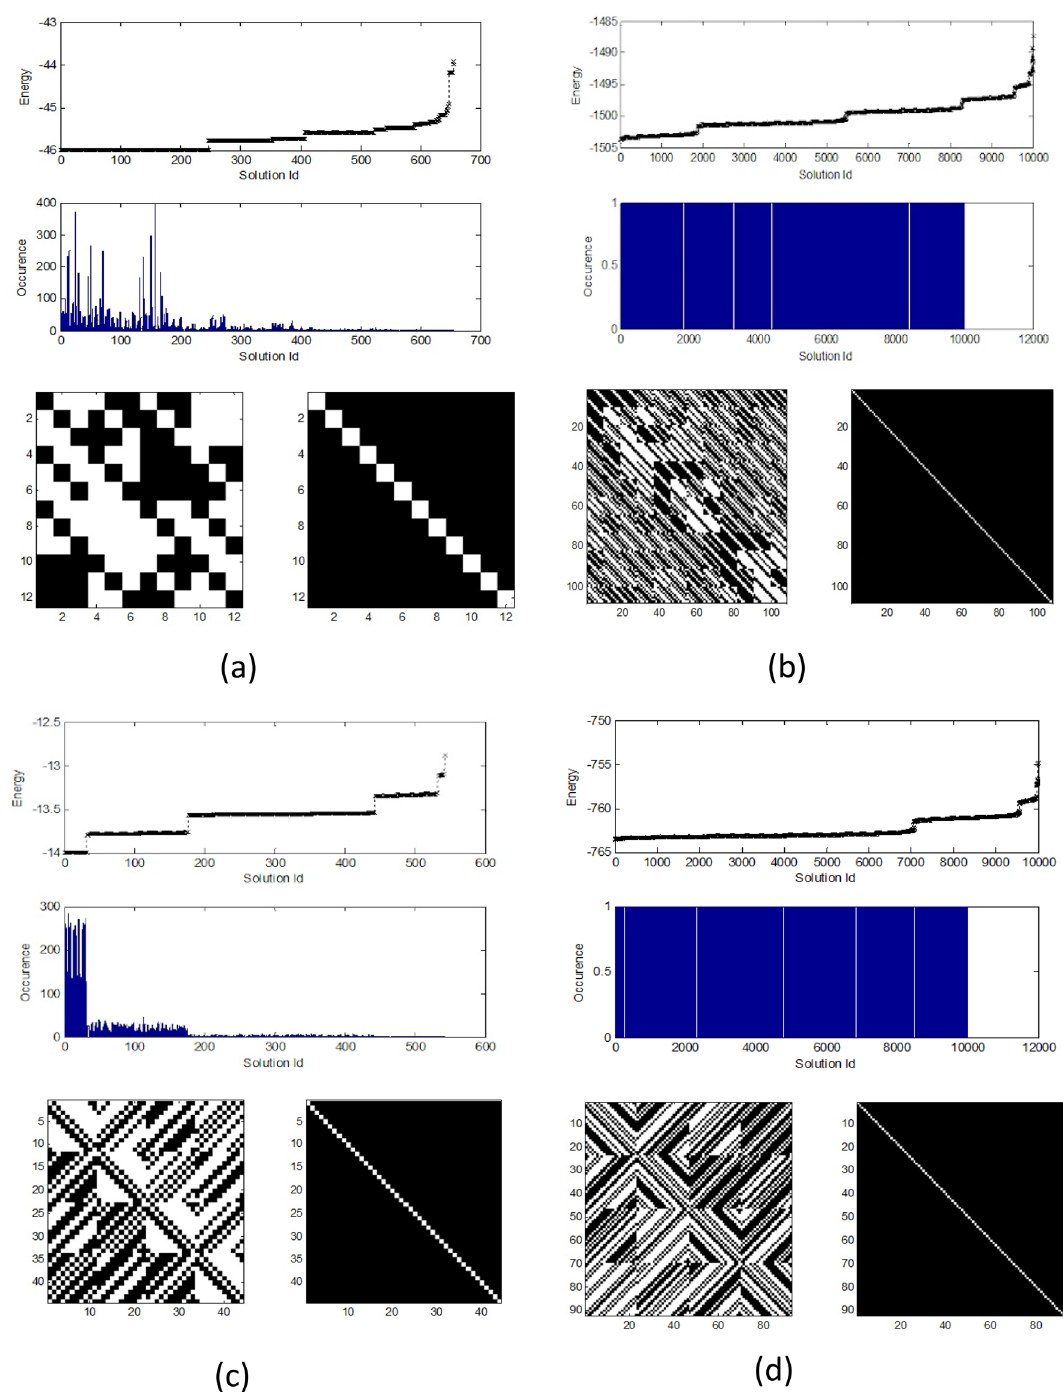
Figure 3. Experiment results of finding H-matrices using a quantum computer (D-Wave): ( a ) Williamson based method yields a 12 order H-matrix, ( b ) Baumert–Hall based method gives 108 order H-matrix, ( c ) Turyn based method resulting a 44 order H-matrix, and ( d ) extension of the Turyn based method that yields a 92 order H-matrix. Top parts show running statistics of the quantum processor. Bottom parts show the obtained H-matrices at the left hand side and corresponding indicator matrix at the right hand side. White pixels in the matrix indicates + 1 , whereas the black one is − 1 . White pixels in the indicator matrix correspond to M ; which is the order of the matrix, and the black ones are zeroes. Running statistics shows that the solutions tend to cluster around low energy for low order case of 12 and 44, whereas they tend to uniformly distributed for high order cases of 108 and